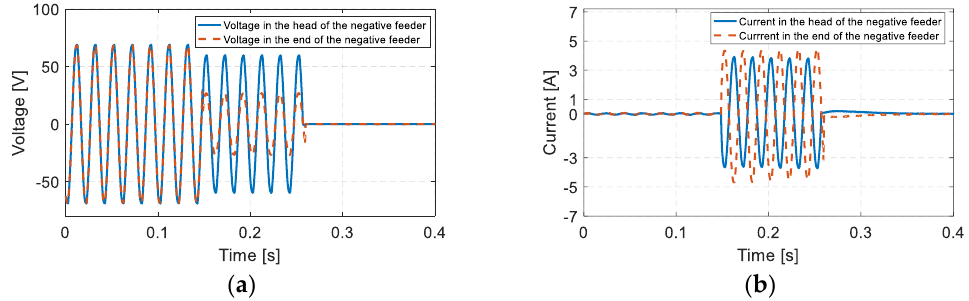
Figure 20. Voltage and current in the negative feeder at the AT subsection 3: ( a ) Voltage in two terminals of the negative feeder and ( b ) current in two terminals of the negative feeder.